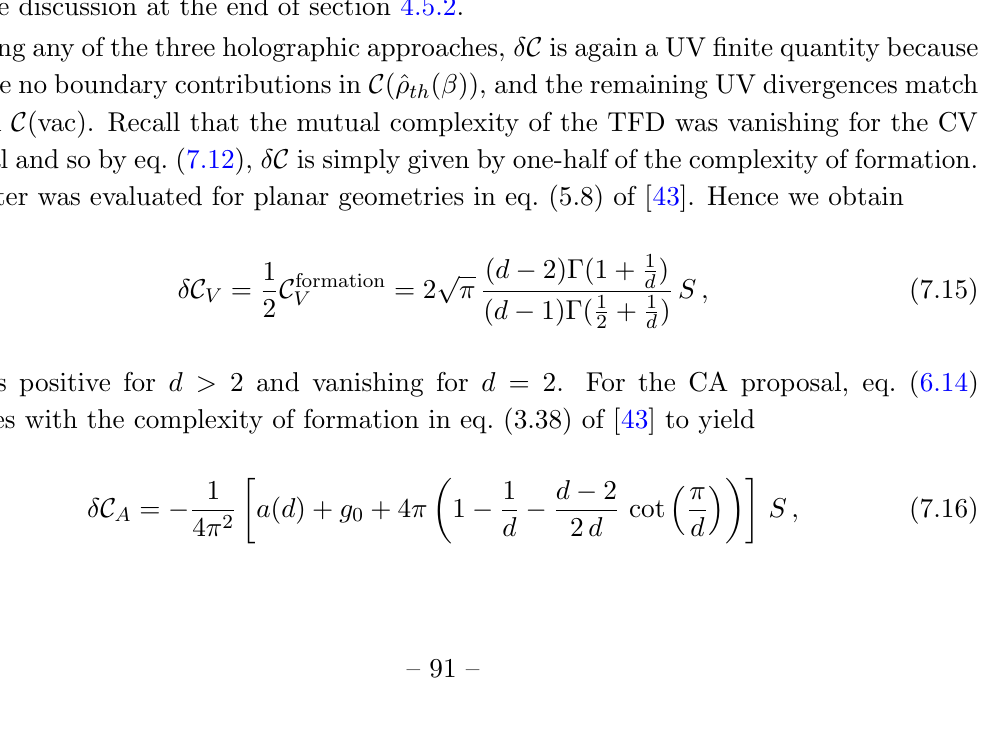
( j TFD i ) as de(cid:12)ned in eq. (7.12) with (cid:12)xed (cid:22) r = 1 1 12 is always 1